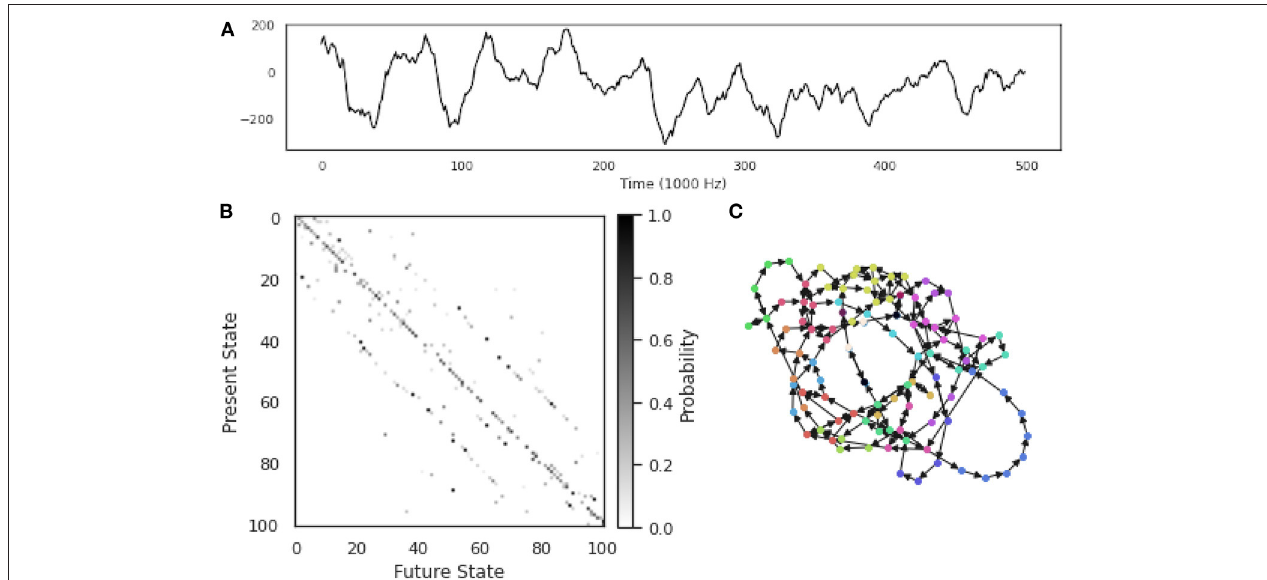
FIGURE 4 | Constructing an Ordinal Partition Network from a single time series. An example of an OPN constructed from a single ECoG time series taken from the Neurotycho database (Nagasaka et al., 2011). (A) The time series itself: an electrophysiological time series recorded using invasive intra-cortical arrays. (B) The transition probability matrix for the OPN. (C) The OPN itself, nodes colored by community assignment determined using the Informap algorithm (Rosvall and Bergstrom, 2008; Rosvall et al., 2009). Note the mixture of long, path-like cycles corresponding to rare excursions through state-space, as well as denser regions with a high degree of